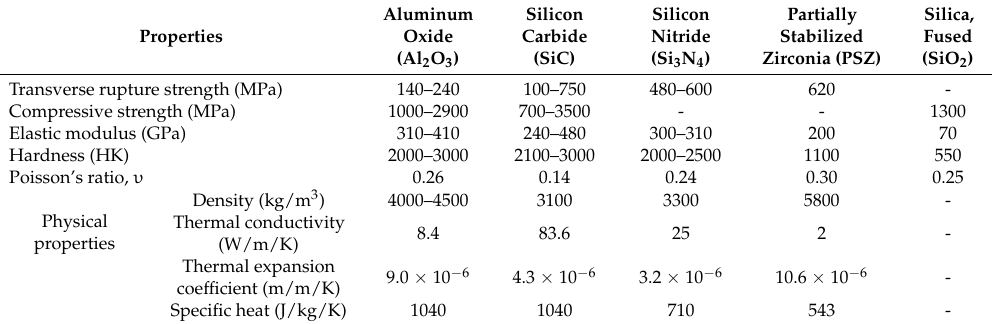
Table 2. Properties of different ceramics